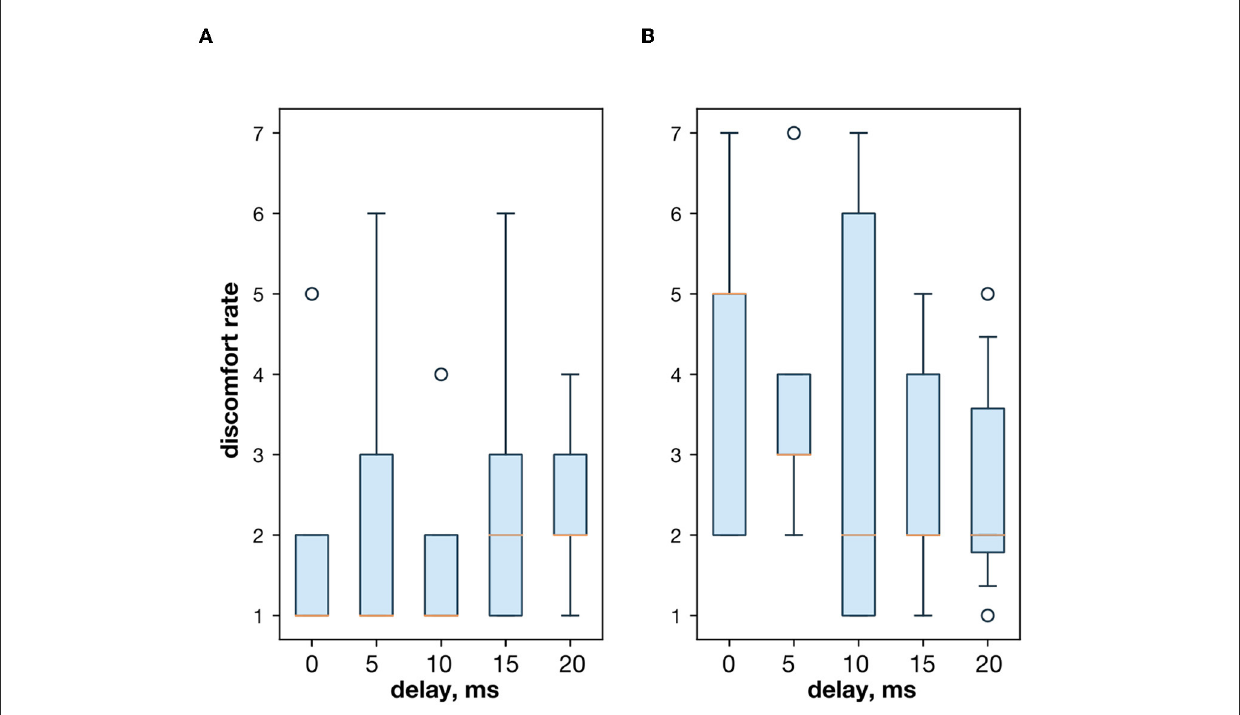
FIGURE4 (A) The discomfort rate with the extensor and flexor muscle stimulation. (B) The discomfort rate with the extensor muscle and the ulnar nerve stimulation.